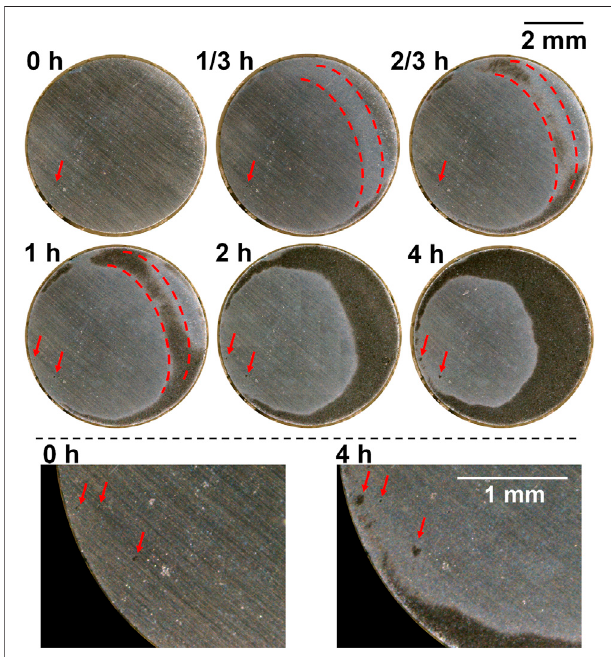
FIGURE 6 | Macrographs of the surface of the sample after heat treatment with the cooling rate 2 ° C/s presenting crevice corrosion development at 0.15 V vs. OCP in 0.1 M NaCl, taken by the self-designed device (lower part shows bottom left of the surface).